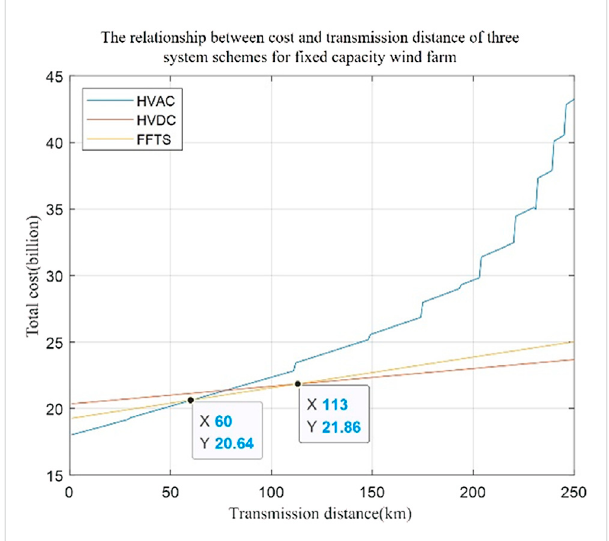
FIGURE 3 Comparison of cost distance curves of three system schemes under AC grid connection of 1400 MW wind